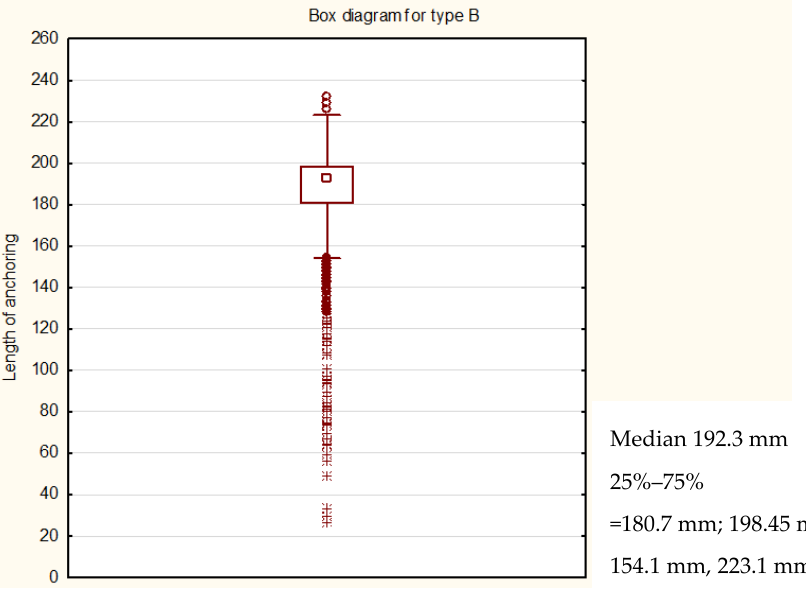
Figure 4. Box diagram for type B anchoring.